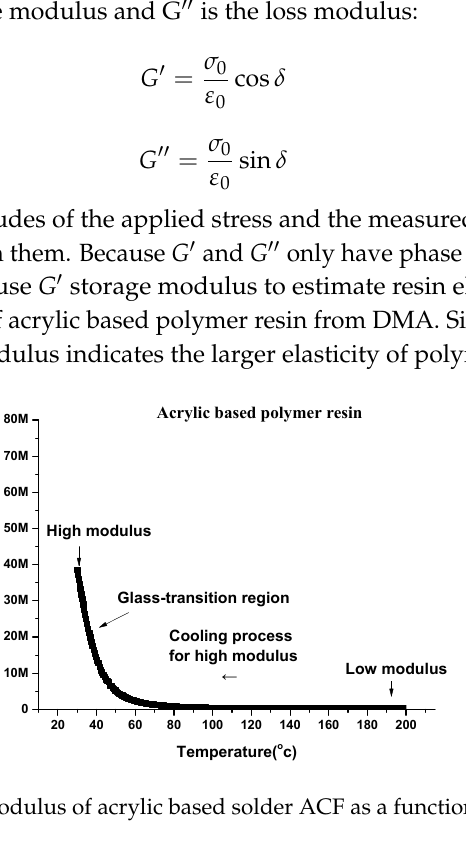
Figure 17. Storage modulus of acrylic based solder ACF as a function of temperature.